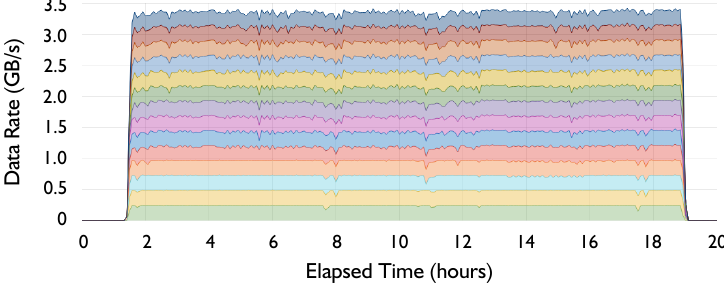
Figure 3. CTA scale tests and stress tests—performance of metadata operations